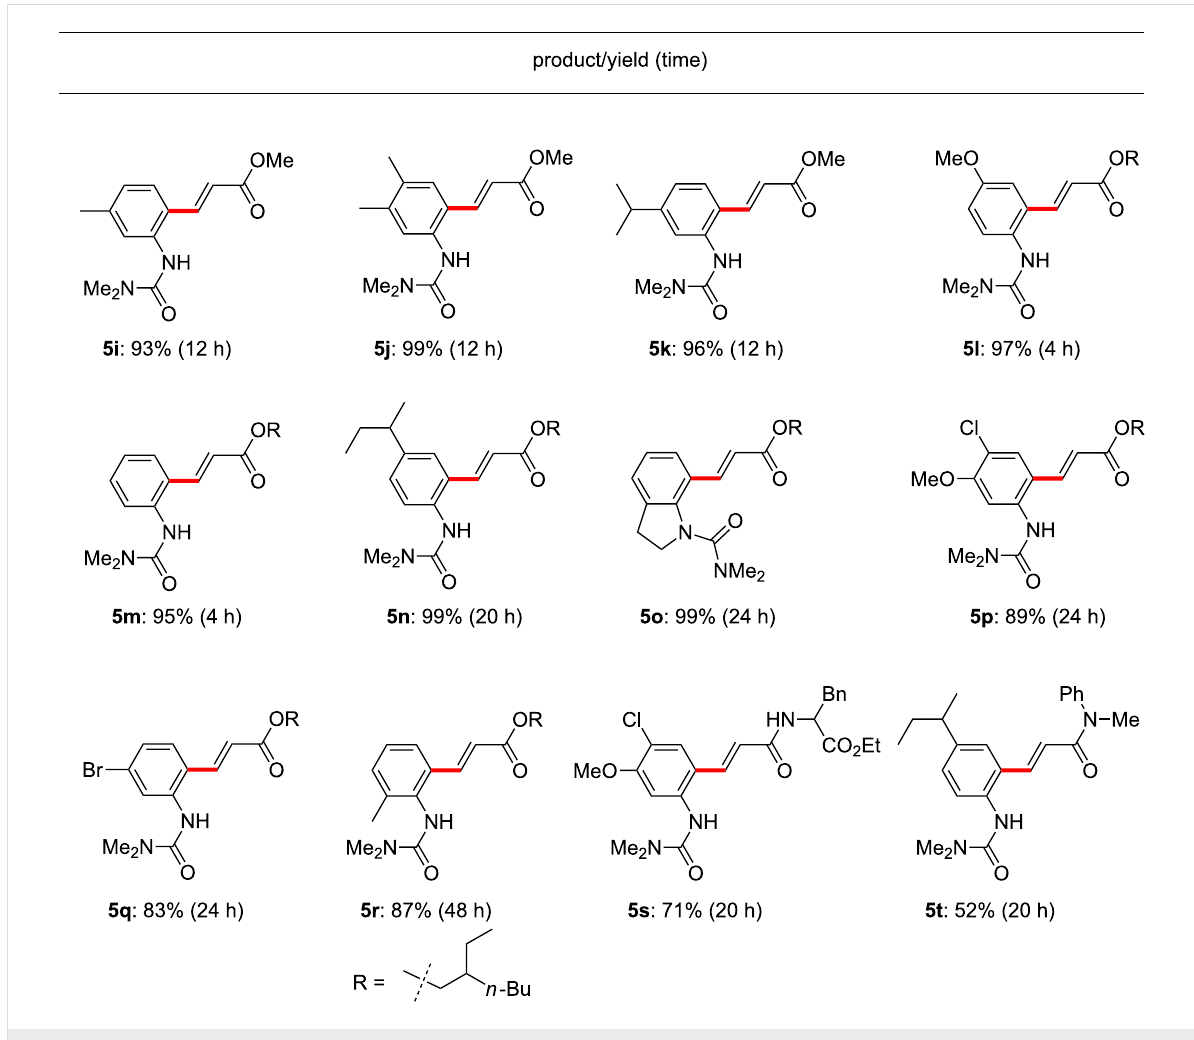
Figure 6: Representative results in EtOAc. Conducted at rt in EtOAc with 10 mol % Pd(OAc) 2 , HBF 4 (1 equiv), arylurea ( 1 , 0.25 mmol), BQ (3 equiv) and acrylate ( 2 , 2.0 equiv).